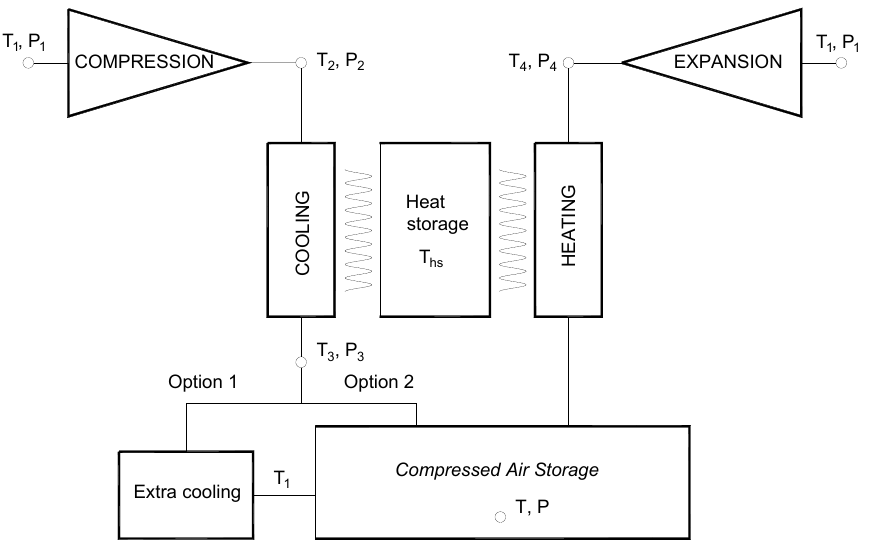
Figure 2. Thermodynamic processes of compressed air energy storage (CAES) (Modified from [7]).